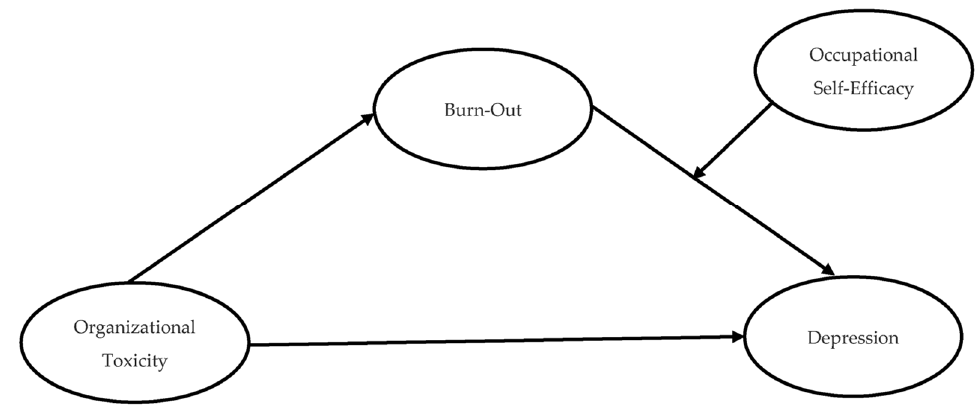
Figure 1. Conceptual model.